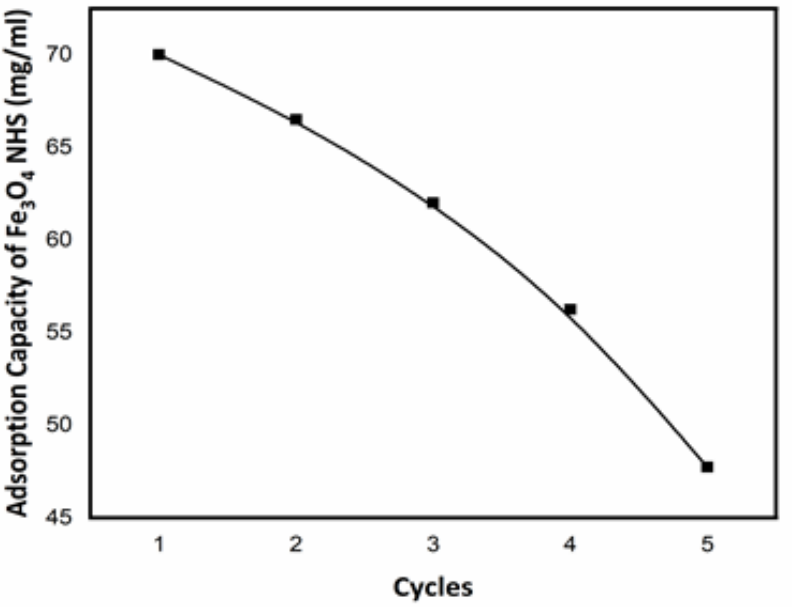
Figure 13. Decrease in adsorption efficiency ( η ) of Fe 3 O 4 NHS (mg/g) over the number of cycles applied on TNT wastewater.